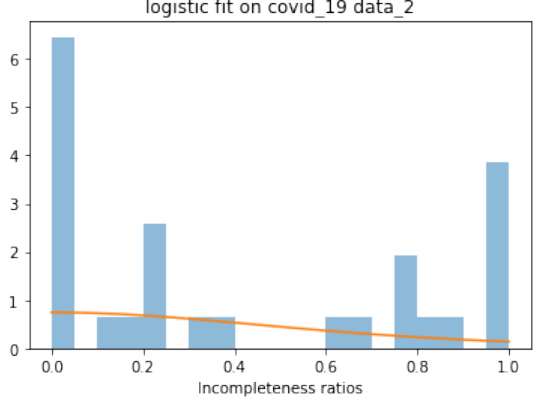
Figure 7. Fitting NNDSS Dataset with logistic distribution.